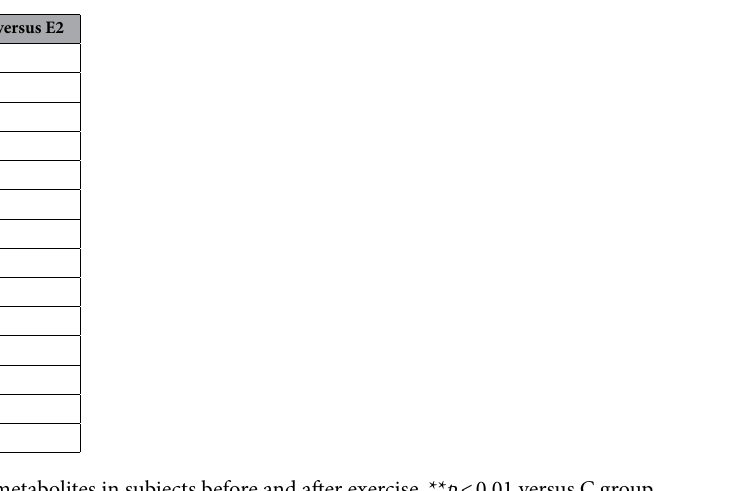
Table 2. Different metabolites and changed trend of rat myocardium in C/E group. ** p < 0.01 versus C group, * p < 0.05 versus C group; ↑ and ↓ maen increase and decrease of metabolite levels.